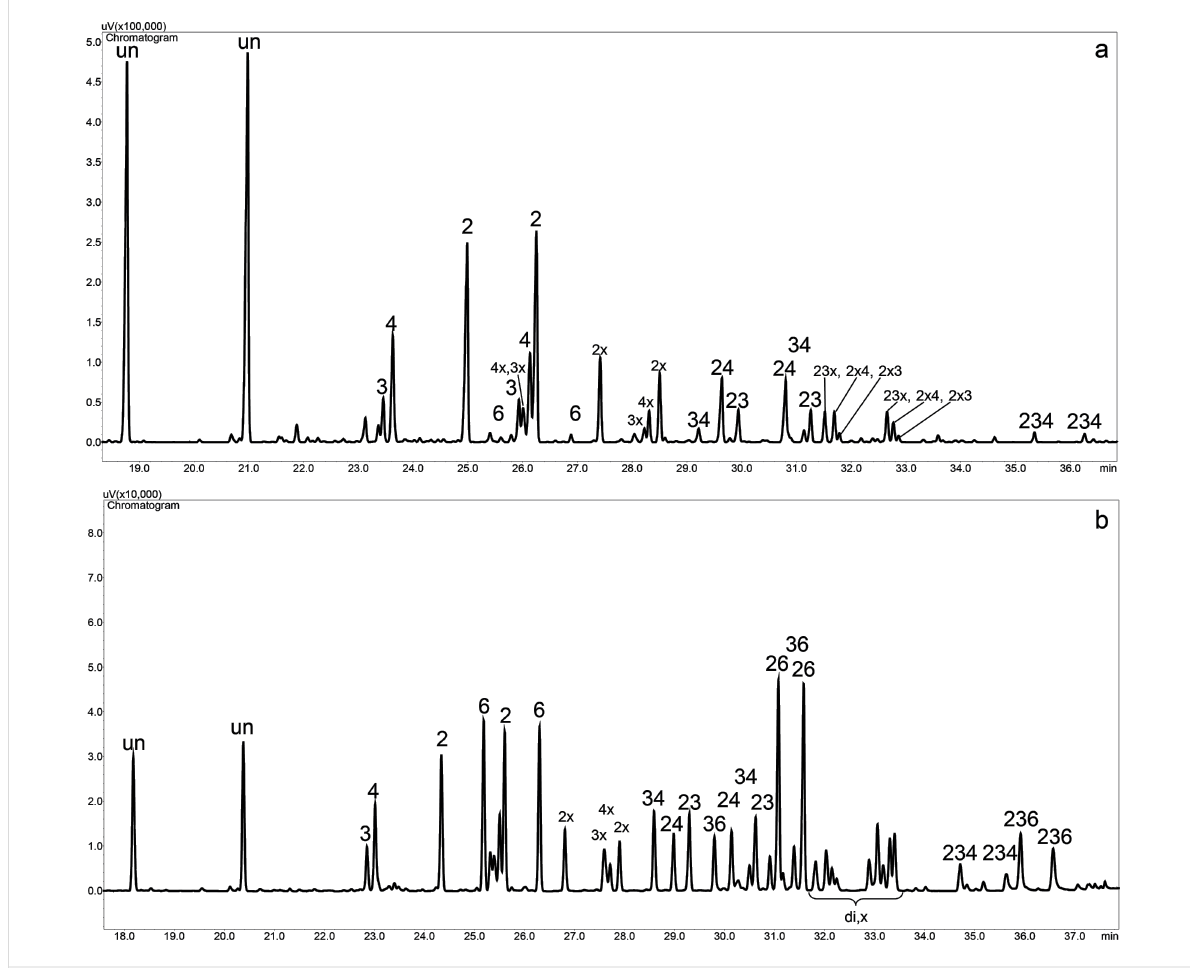
Figure 6: Gas chromatogram of hydrolyzed and trimethylsilylated cyanoethylglucans; (a) CED-1 (DS GC = 0.74); (b) CEP-2 (DS GC = 1.52); x = side products with hydrolyzed cyanonitrile, i.e., carboxyethyl-TMS-ester group; di,x = 3x,6CE, 2 or 4x,CE, 2x,6CE, 3x,6CE, 2 or 4x,CE, 2x,6CE); un: unsubstituted